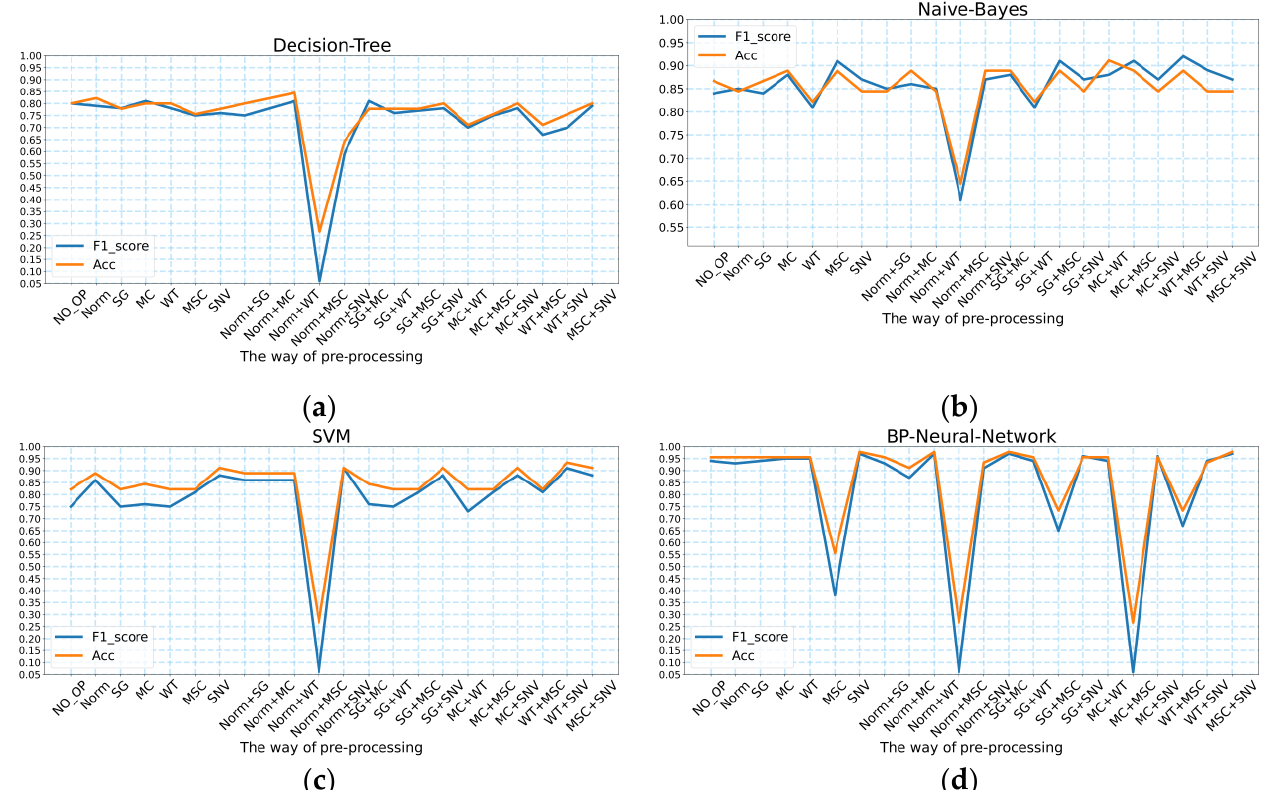
Figure 4. The accuracy and F1_score values of the four models under different pre-processing methods: ( a ) decision tree; ( b ) naive Bayes; ( c ) SVM; ( d ) BP neural network.